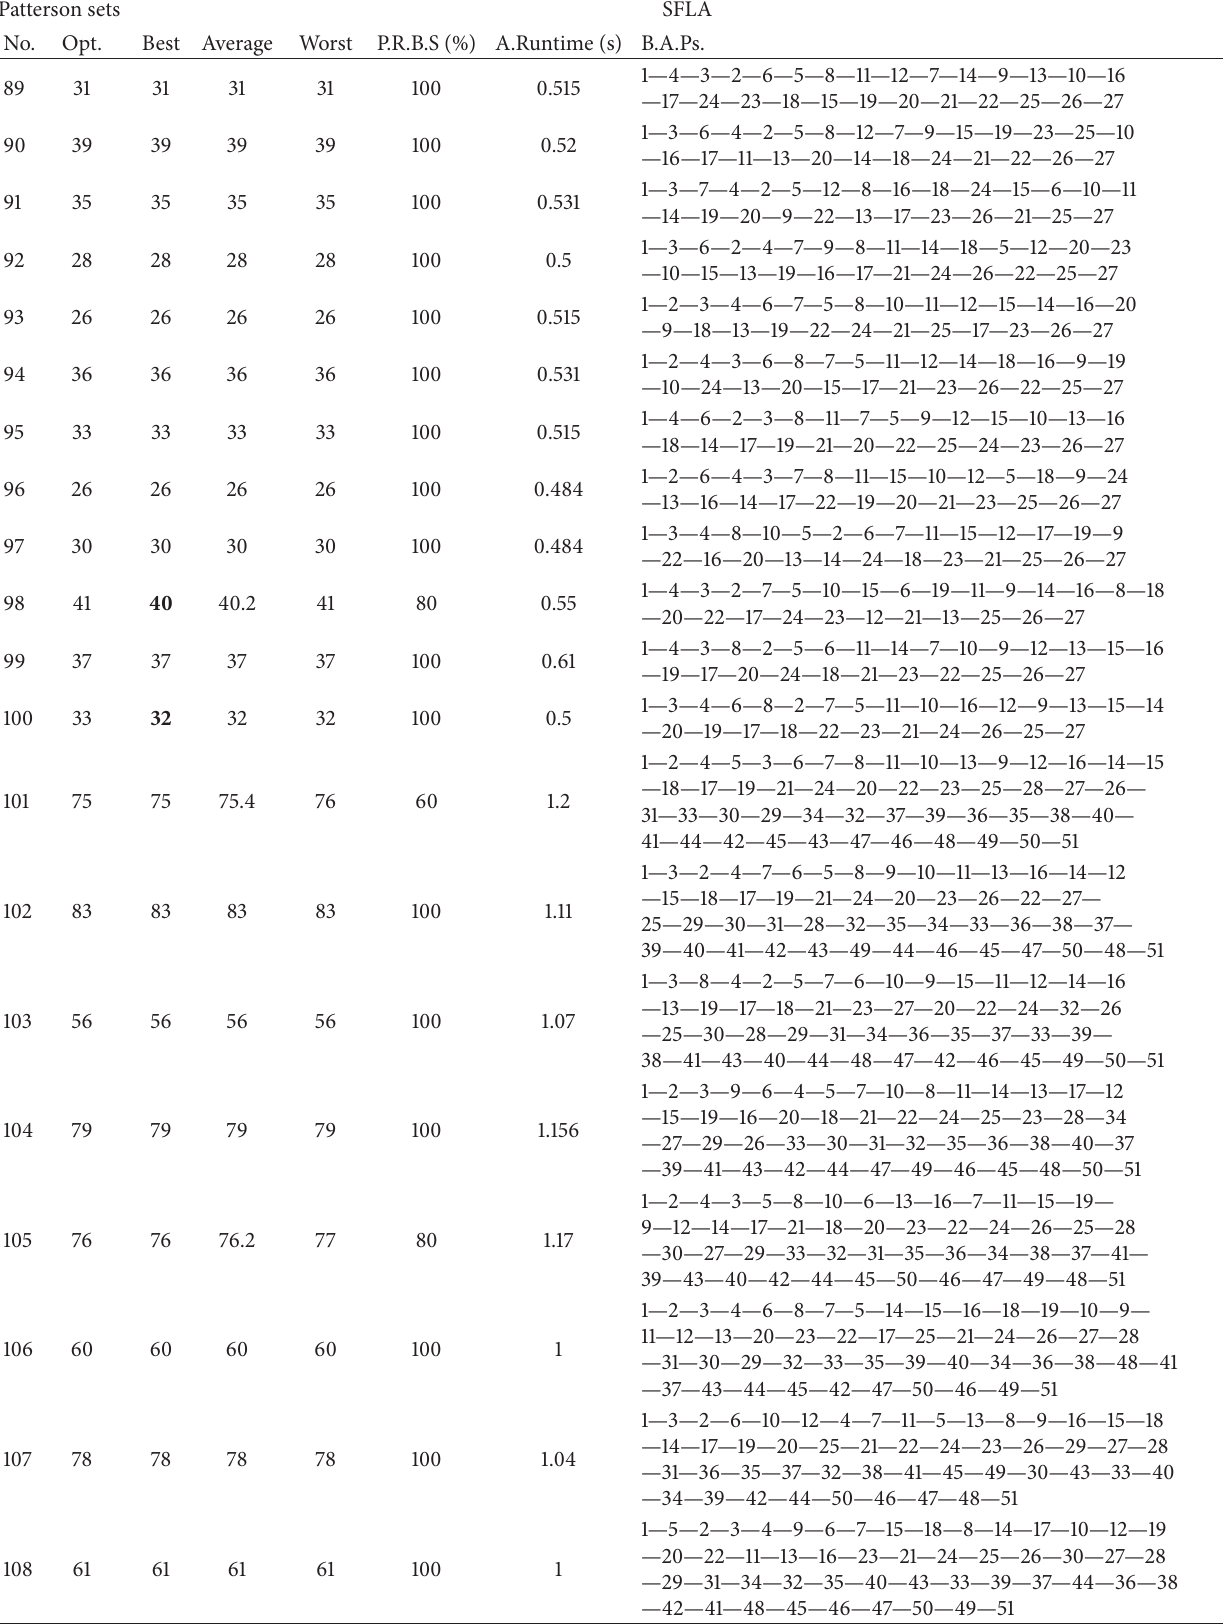
Table 5: Computational results of RCPSP PA SFLA for Patterson set